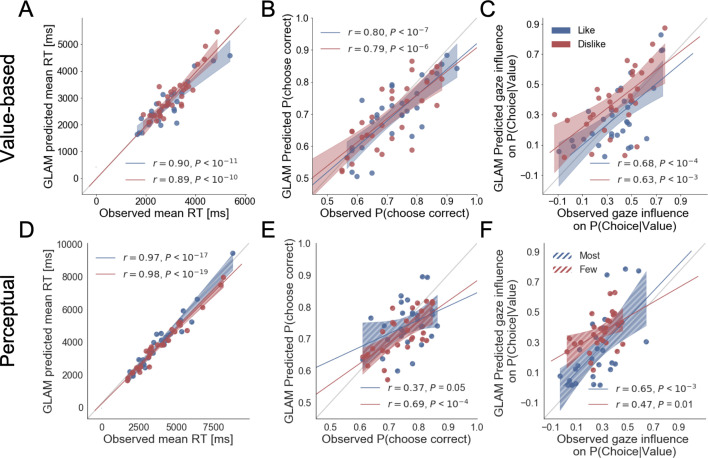
Individual out-of-sample GLAM predictions for behavioural measures in Value (A-C) and Perceptual Experiments (D–F).In value-based decision, (A) the model predicts individuals mean RT; (B) the probability of choosing the item with higher value in like frame, and the item with lower value in dislike frame; and (C) the influence of gaze in choice probability. In the Perceptual Experiment, (D) the model also predicts RT and (F) gaze influence. (E) The model significantly predicts the probability of choosing the best alternative in the fewest frame only (in the most frame a trend was found). The results corresponding to the models fitted with like/most frame data are presented in blue, and with dislike/fewest frame data in red. Dots depict the average of observed and predicted measures for each participant. Lines depict the slope of the correlation between observations and the predictions. Mean 95% confidence intervals are represented by the shadowed region in blue or red, with full colour representing Value Experiment and striped colour Perceptual Experiment. All model predictions are simulated using parameters estimated from individual fits for even-numbered trials.